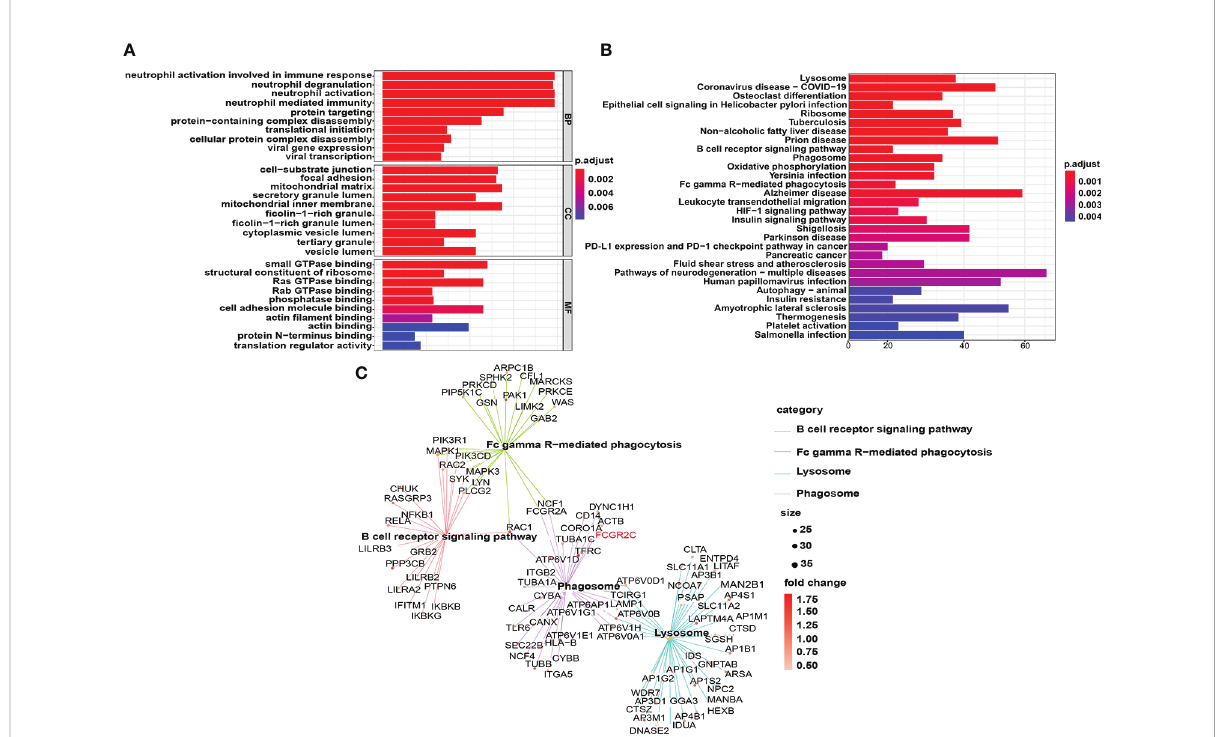
FIGURE 8 Functional enrichment analysis of DEGs in the discovery cohort. (A) The top 10 results of the cellular component (CC), molecular function (MF), and biological process (BP) categories in GO enrichment analysis are shown. (B) The top 30 KEGG enrichment results with the most signi fi cant P-values are displayed. (C) Genes enriched in the B-cell receptor signaling pathway, Fc gamma R-mediated phagocytosis, lysosome, and phagosome in the KEGG results are